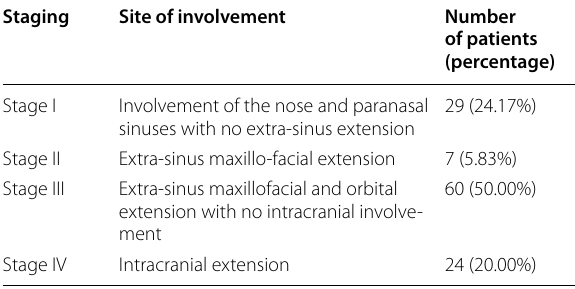
Table 3 MRI staging of patients with COVID-19-associated